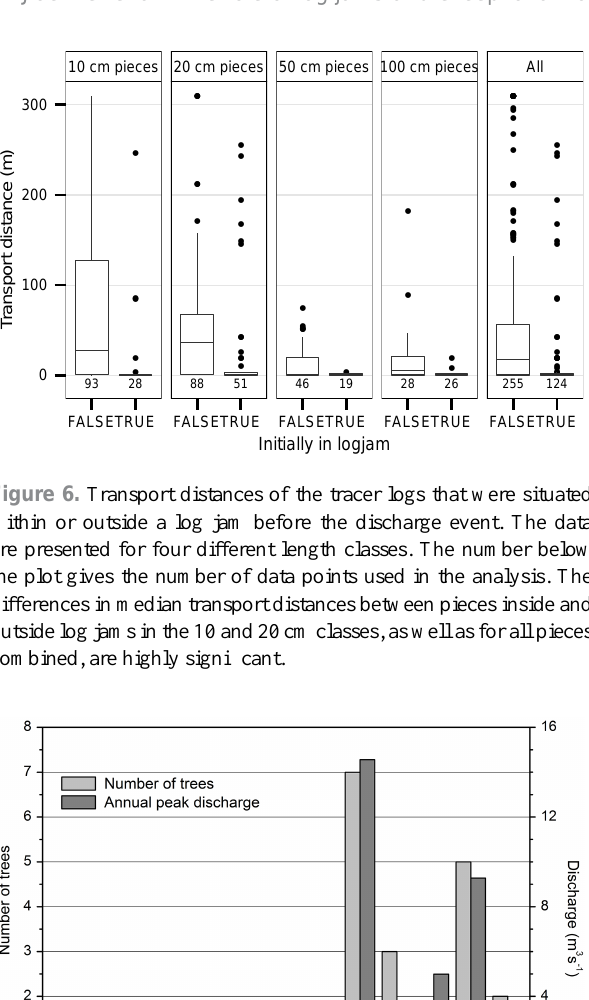
Figure 7. Histogram of kill dates of trees stored within the nine log jams (cf. Table 3) in the study reach of the Erlenbach (light grey) and annual peak discharges in the respective years (dark grey).